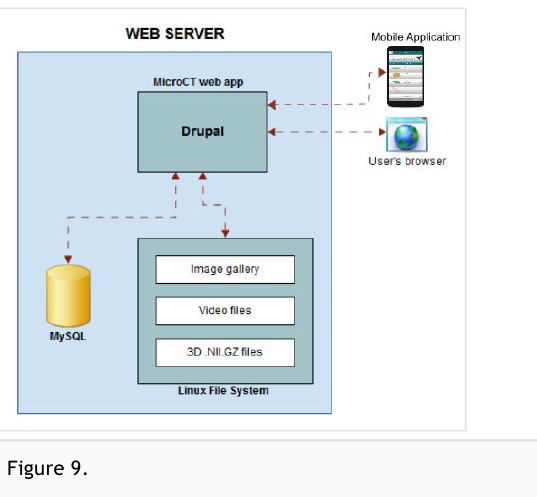
: architecture of the web application.